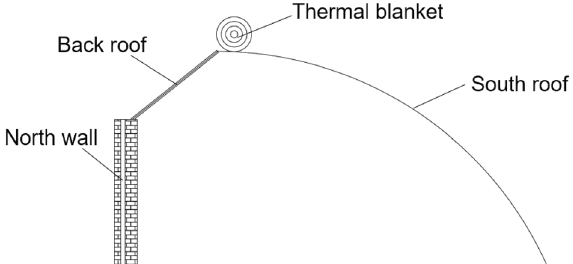
Figure 1. Cross-section of the Chinese solar greenhouse (CSG). The envelope consists of a north wall, side walls, and a back roof. The south roof is covered by transparent